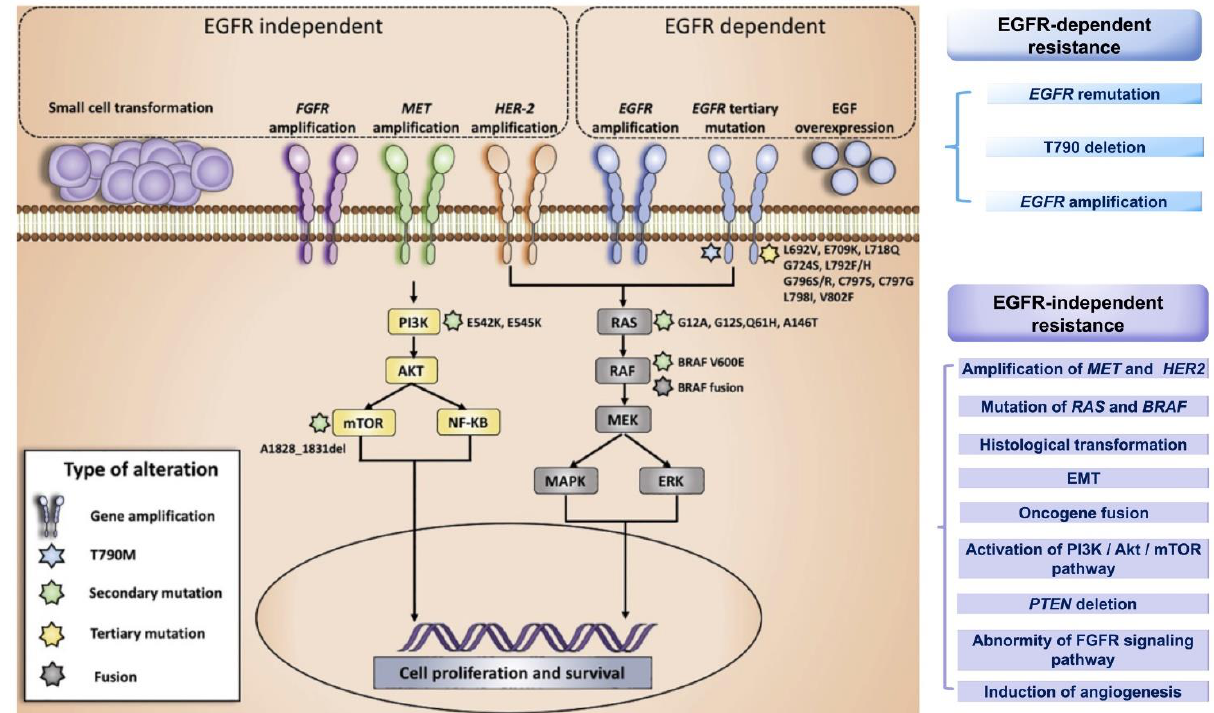
Figure 3. The acquired resistance mechanisms to third-generation EGFR-TKIs can be classified as EGFR-dependent resistance and EGFR-independent resistance. The EGFR-dependent mechanism: EGFR re mutation, T790M deletion and EGFR amplification; The EGFR-independent mechanism: amplification of MET and HER2, mutation of RAS and BRAF, histological transformation, EMT, oncogene fusion, activation of the PI3K/Akt/mTOR pathway, PTEN deletion, abnormity of the FGFR signaling pathway, and the induction of angiogenesis. (MET: mitogen activation kinase; EMT: epithelial mesenchymal transition; PTEN : phosphatase and tensin homology; FGFR: fibroblast growth factor receptor; ERK: extracellular regulated protein kinases). Reprinted with permission from ref. [74]. Copyright 2018 Elsevier Table 3. Mechanisms and treatment strategies for resistance to osimertinib.